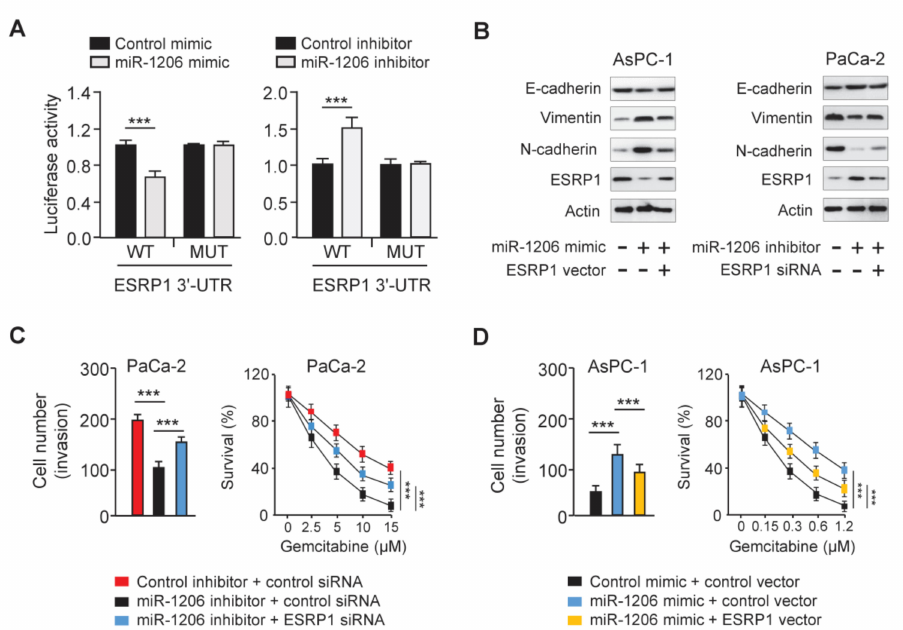
Figure 7. MiR-1206 Enhances PC Cell Invasion and Gemcitabine Resistance via Targeting ESRP1. ( A ) PC cells were transfected with either wild-type (WT) or mutant (MUT) ESRP1 3 (cid:48) -UTR, with miR-1206 mimic or miR-1206 inhibitor, and luciferase reporter assays were performed. ( B ) Protein levels of E-cadherin, N-cadherin, Vimentin, and ESRP1 in PC cells. ( C , D ) Invasion assays (left) and CCK-8 assays (right) in PaCa-2 ( C ) and AsPC-1 ( D ) cells. The experiments in ( A , C , D ) were repeated three times independently with similar results. *** p <0.001.